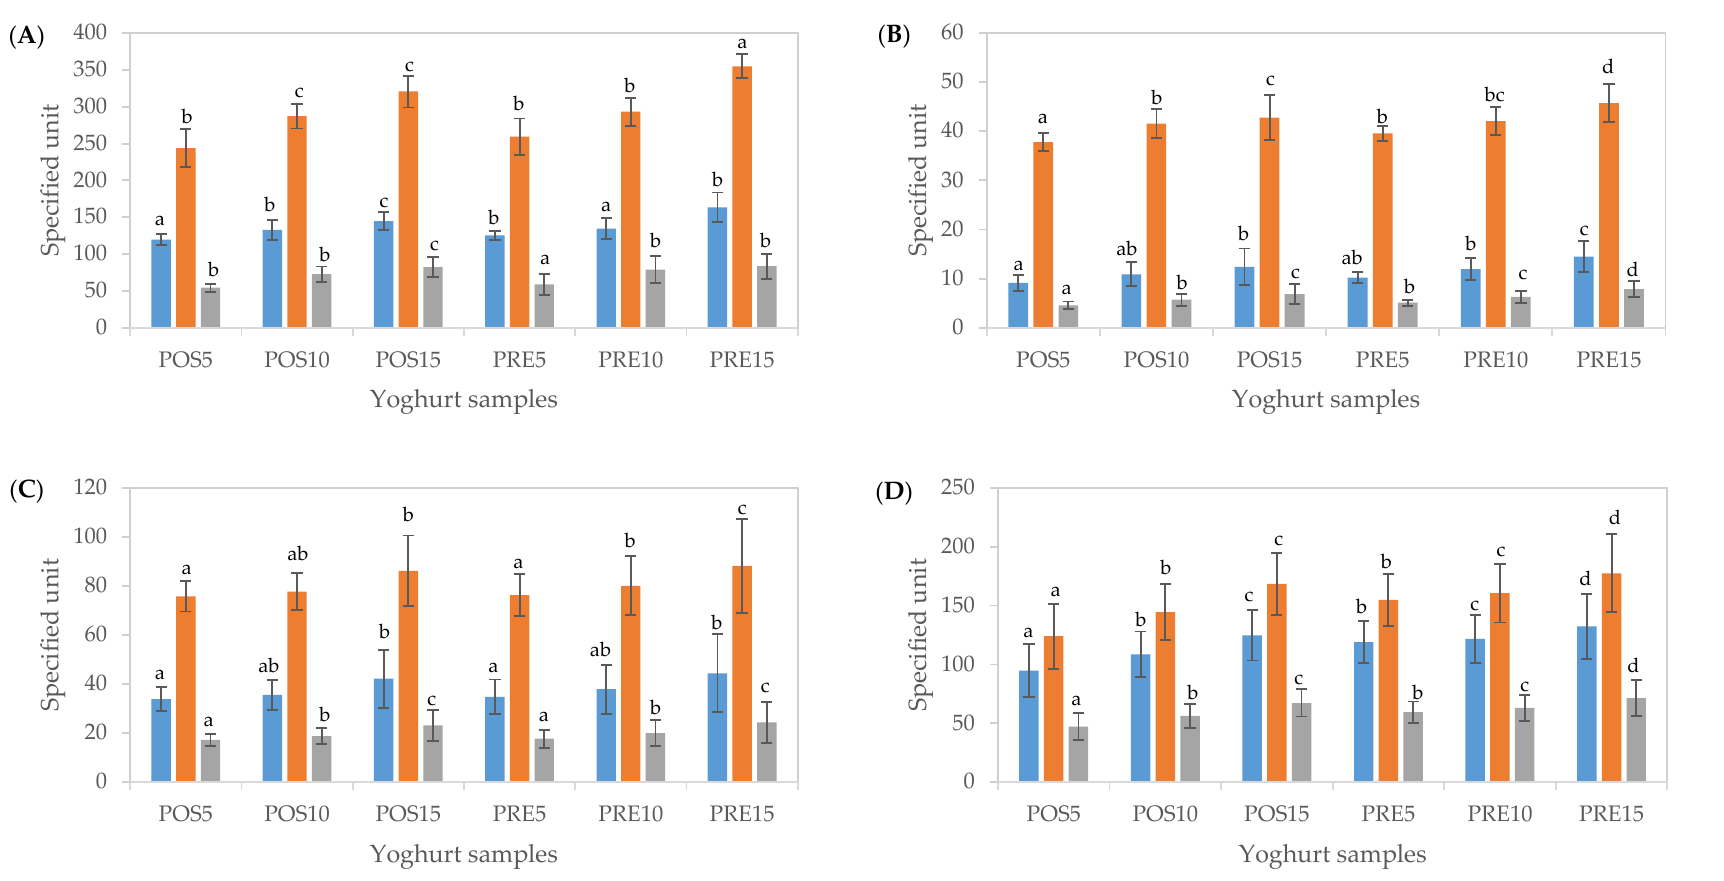
Figure 4. Total phenolic content (TPC) and antioxidant activity (CUPRAC and FRAP assay) of yoghurts fortified with cubosome containing tamarillo extract before digestion ( A ), after oral ( B ), gastric ( C ) and intestinal ( D ) phases of in vitro digestion. The units of TPC ( ◼ ), CUPRAC ( ◼ ) and FRAP ( ◼ ) were mg GAE/100 g yoghurt, μ mol TEAC/100 g yoghurt and μ mol TEAC/100 g yoghurt, respectively. Data are presented as mean and error bar (standard deviation) ( n = 3). Different alphabets indicate statistical difference ( p < 0.05) for each assay.